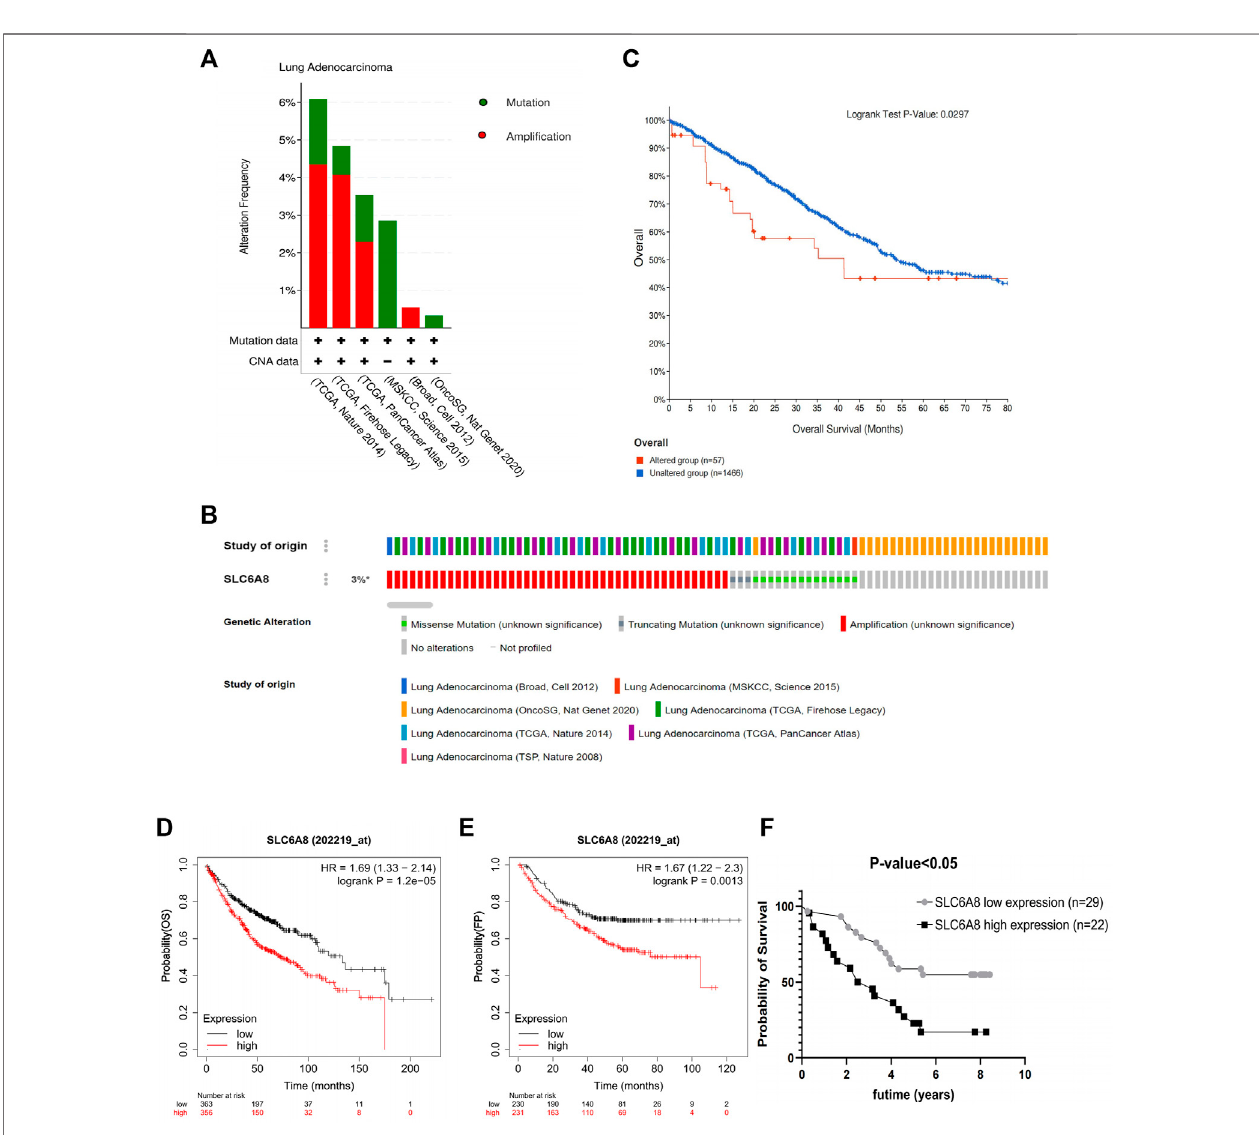
FIGURE 2 | Genetic alteration and prognosis analysis of SLC6A8 in LUAD. (A , B) Genetic alteration analysis of SLC6A8 in LUAD In the eBioportal database. (C) Prognostic analysis of SLC6A8- altered group and SLC6A8- unaltered group in LUAD. Correlation of SLC6A8 in LUAD with (D) OS and (E) FP as per the results of the Kaplen_Meier plotter online website (F) Survival analysis of SLC6A8 expression in TMA2 clinical follow up data information.